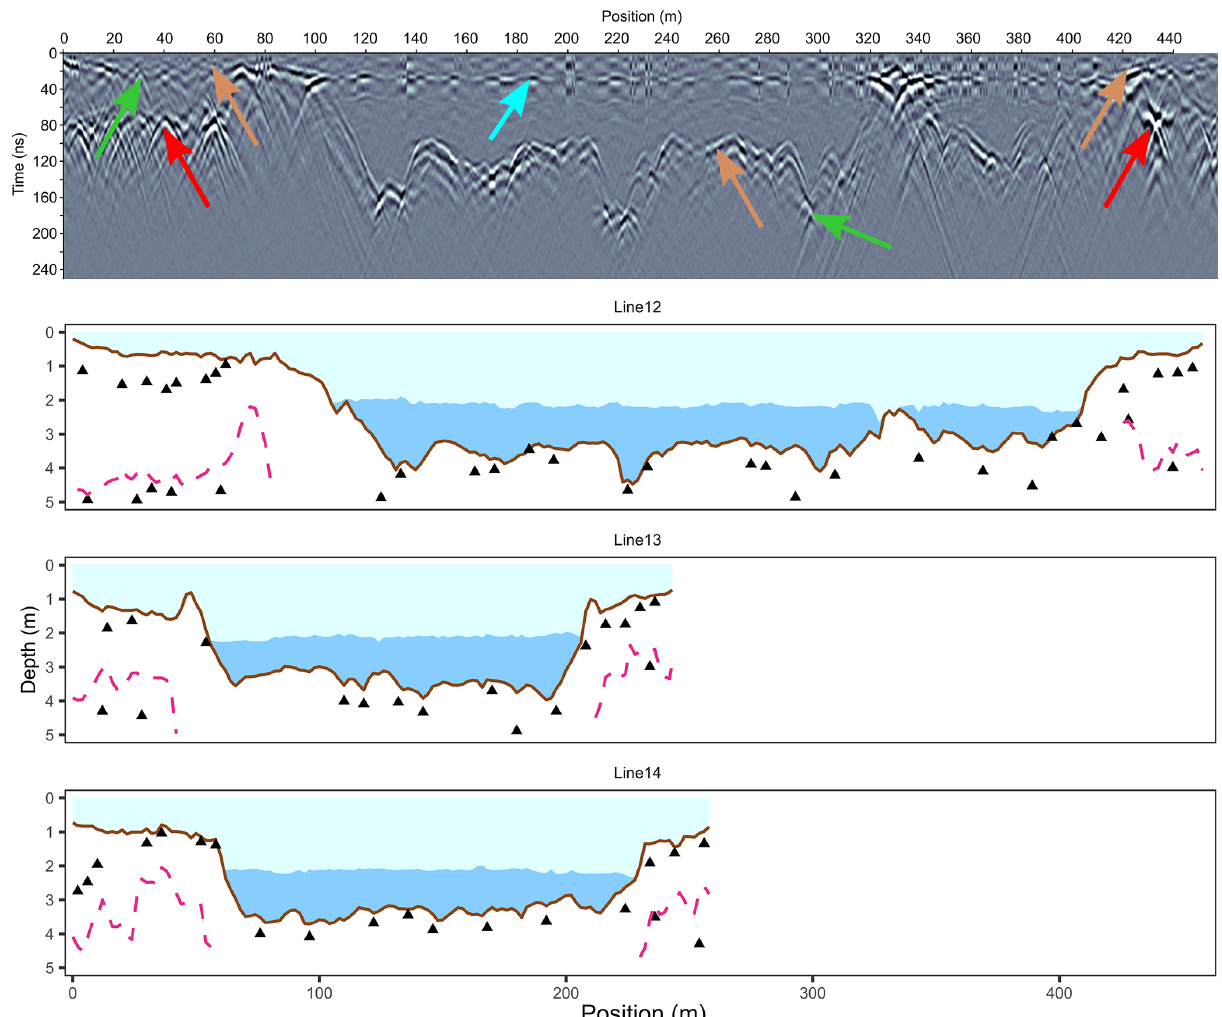
Figure 3. Interpreted GPR cross sections obtained along survey lines (see Fig. 2 for line locations). The upper figure is the raw GPR profile for line 12, with color arrows indicating distinct reflectors such as the base of the ice cover (light blue), lake bottom (brown), former surface of ice-wedge polygon ridges and troughs (green), and the top of the glacio-fluvial sand and gravel unit (red). Lower figures are interpretations, showing the ice cover (light blue area), free water area (dark blue area), lake bottom (brown line), glacio-fluvial stratigraphic contact (pink dashed line) and identified local reflectors, pictured as triangles. Complete data (Fortier et al., 2019) are available in open-access files (see “Data availability”